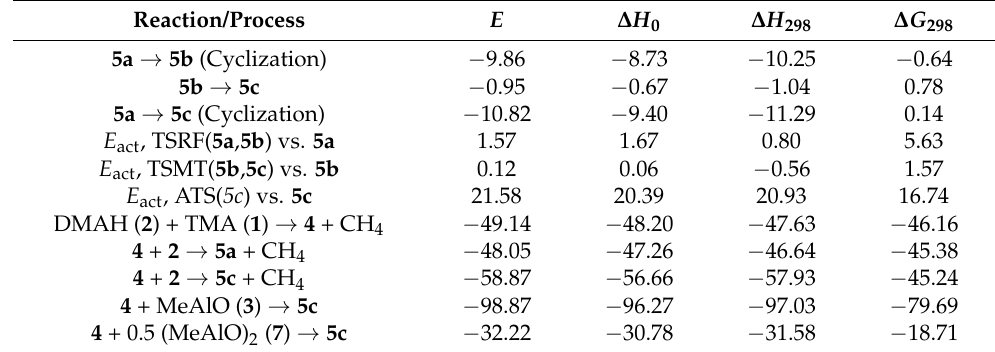
Table 1. Computed Relative and Reaction Energies of Formation of Permethyltrialuminoxane 5 and Isomerization of 5 (kcal/mol).